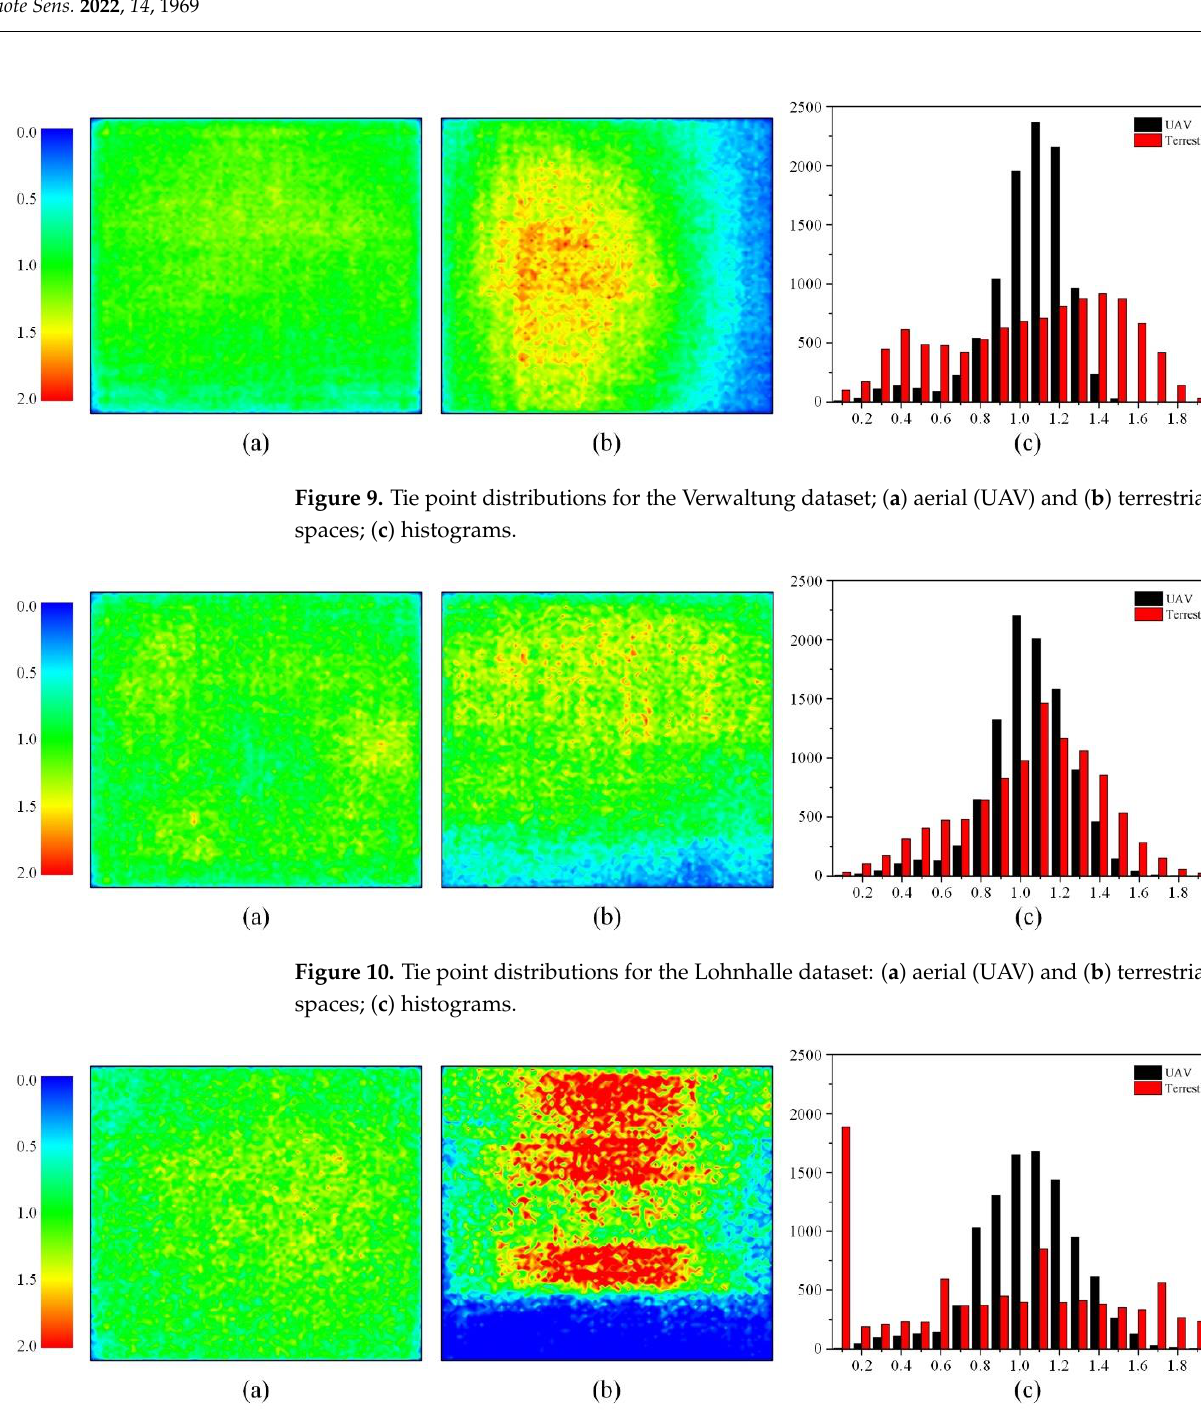
Figure 11. Tie point distributions for the SWJIT-LIB dataset: ( a ) aerial (UAV) and ( b ) terrestrial image spaces; ( c ) histograms.